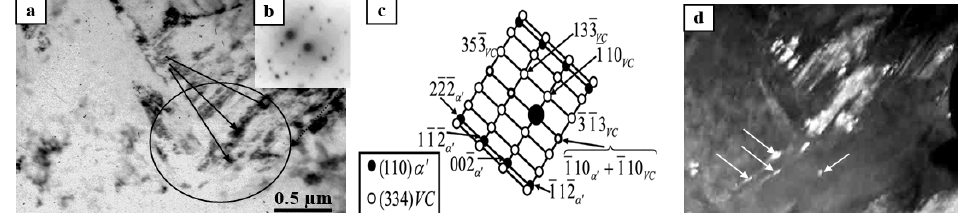
Figure 4. TEM image of the location of vanadium carbide in R6M5steel ( a )—the bright field image; ( b )—microdiffraction pattern; ( c )—the indicated microdiffraction pattern, ( d )—the dark-field image obtained in the VC carbide reflex (marked by arrows).